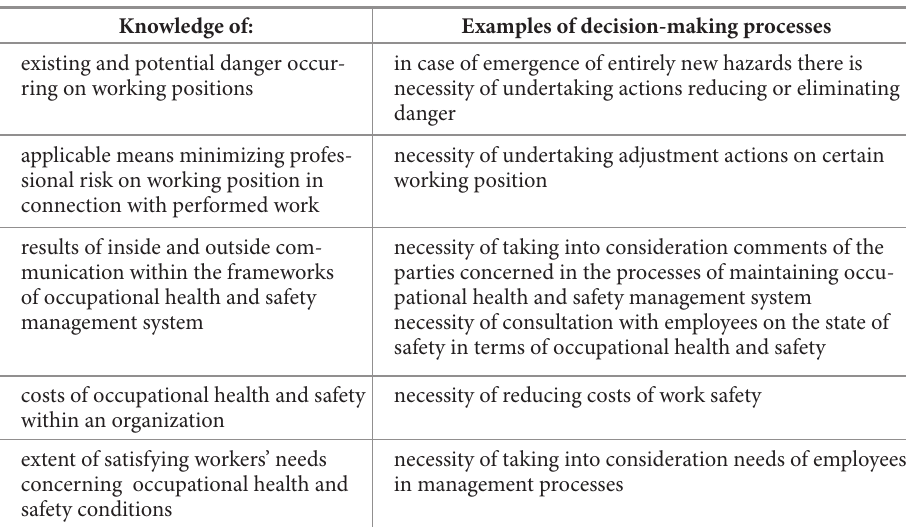
Table 8. Examples of decision-making processes using acquired OHSAS knowledge Knowledge